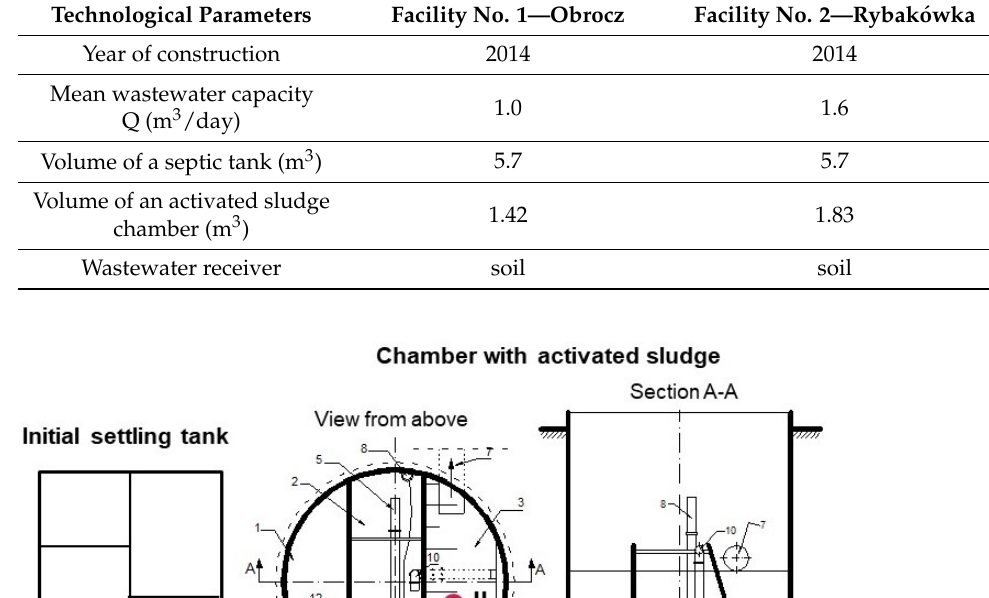
foundation. Table 1. Technological parameters of the household WWTPs in the area of the RNP. Technological Parameters